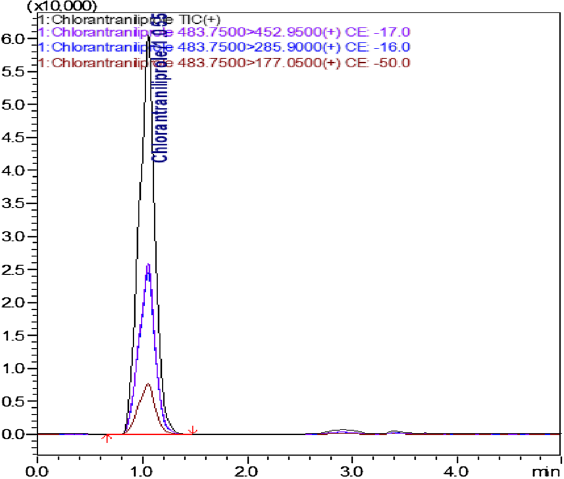
Figure 1. LC–MS/MS determination of chlorantraniliprole along with the MRM at 0.1 µg g −1 .